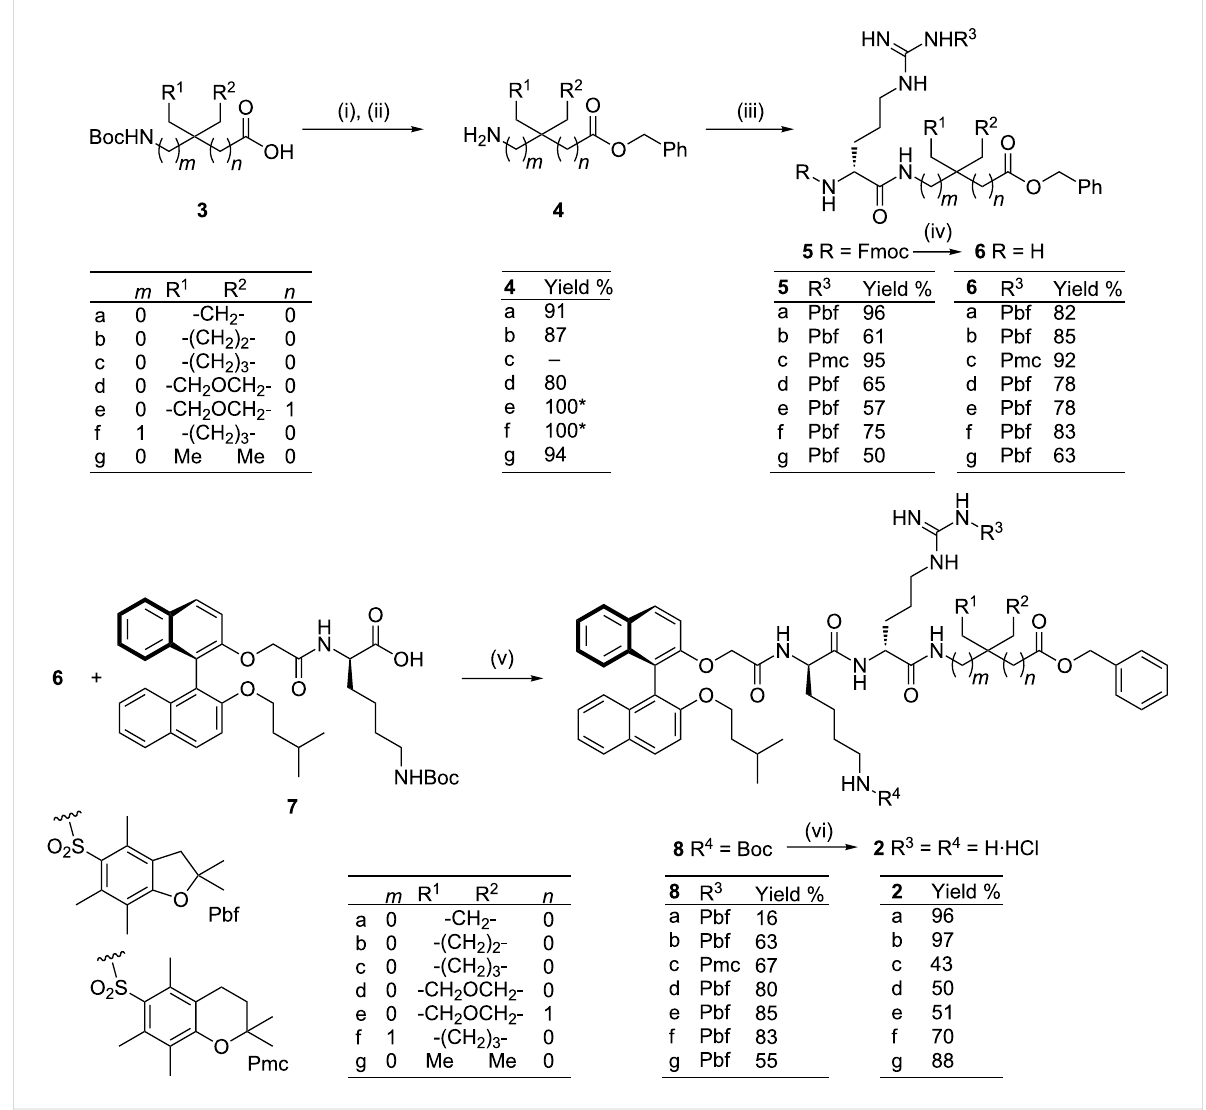
Scheme 1: Synthesis of compounds 2a – g . Reagents and conditions: (i) 2a – b , d – g , BnBr, acetone or THF, K 2 CO 3 , reflux, 3–12 h; (ii) TFA, DCM, rt, 1–2 h, 2 M HCl/Et 2 O (HCl salts); (iii) 5a – f : (DIPEA), Fmoc-( R )-Arg(Pmc)-OH ( 5c ) or Fmoc-( R )-Arg(Pbf)-OH ( 5a – b , d – f ), EDCI, HOBt, CH 3 CN, rt,